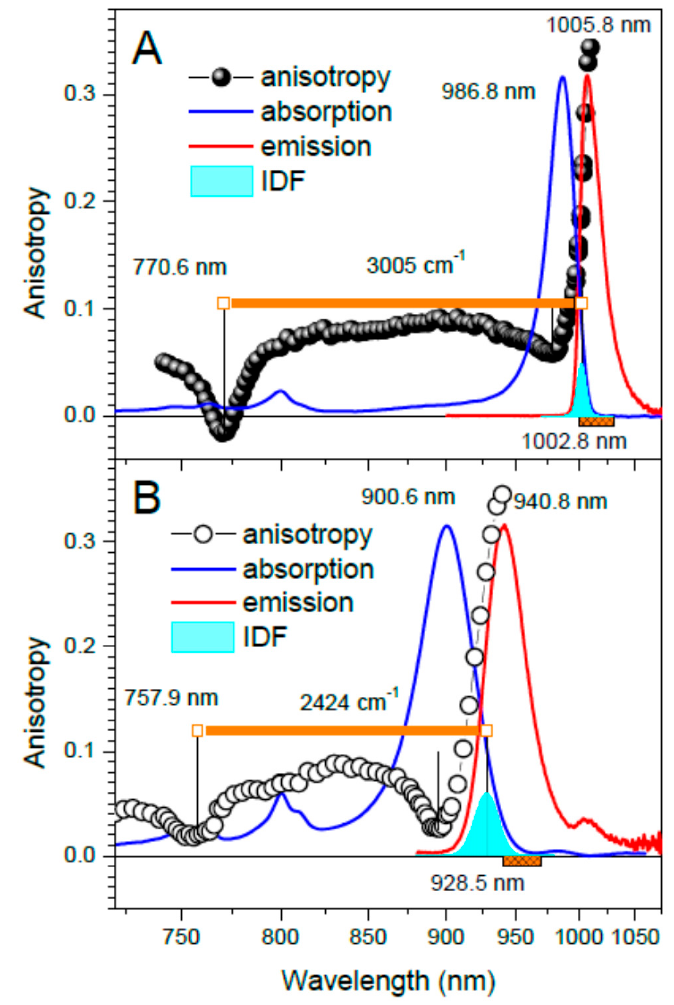
Figure 1. Fluorescence anisotropy excitation spectra of Ca-LH1-RC ( A , black balls) and LH1-RC ( B , black open rings) complexes of Trv. 970 along with the respective inhomogeneous spectral distribution of the k = 0 exciton states, IDF (cyan). Thin vertical black lines outline the exciton band borders, while bold orange horizontal lines define the exciton bandwidths. Shown on the background are the absorption (blue line) and fluorescence (red line, excited non-resonantly at 407 nm) spectra. The group of bands around 800 nm belongs to the RC complex. The approximately Gaussian-shape IDF was arbitrarily scaled with respect to corresponding absorption spectra. The spectra recorded at 4.5 K were for convenience of comparison plotted in linear in energy reciprocal wavelength scale. Orange patterned stripes indicate the fluorescence recording ranges applied in anisotropy measurements.